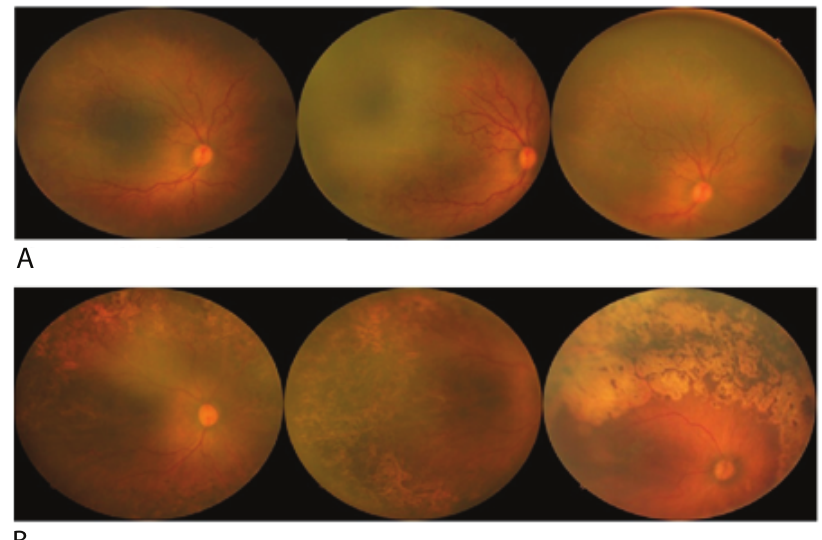
Figure 1. Fundus photos of eyes pre- (A) and post-laser (B).